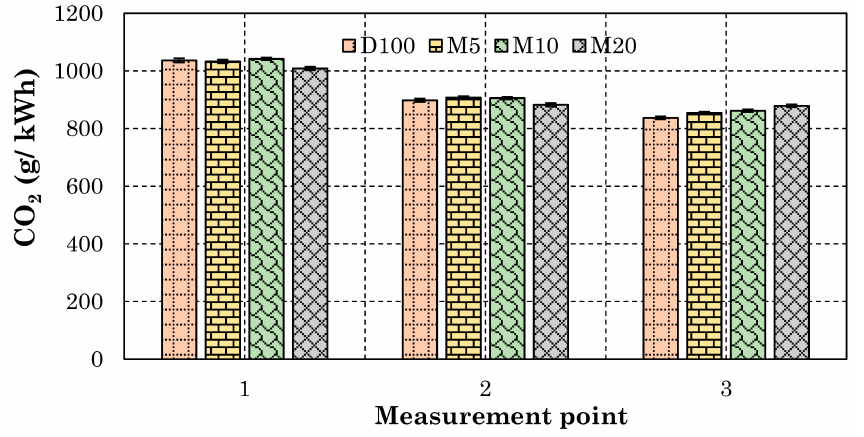
Figure 9. Specific emissions of CO 2 for all test fuels at all measurement points (error bars represent the standard